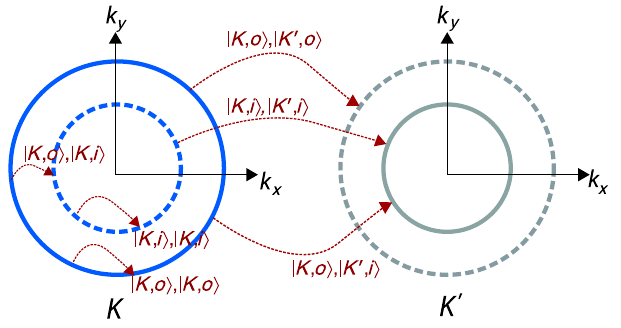
FIG. 6. Schematic illustration of the inner and outer contours of the Fermi surface around the K and K 0 points that cross the Fermi level [cf. Fig. 2(b)]. Solid circles represent pseudospin j ↑ i states and dotted circles represent pseudospin j ↓ i states. The possible pairing interactions due to phonons or spin fluctuations between the pseudospin states are denoted with red dotted arrows. The relative signs of these interactions are summarized in Table II. Subscript o refers to the outer contour and the subscript i refers to the inner contour at a given